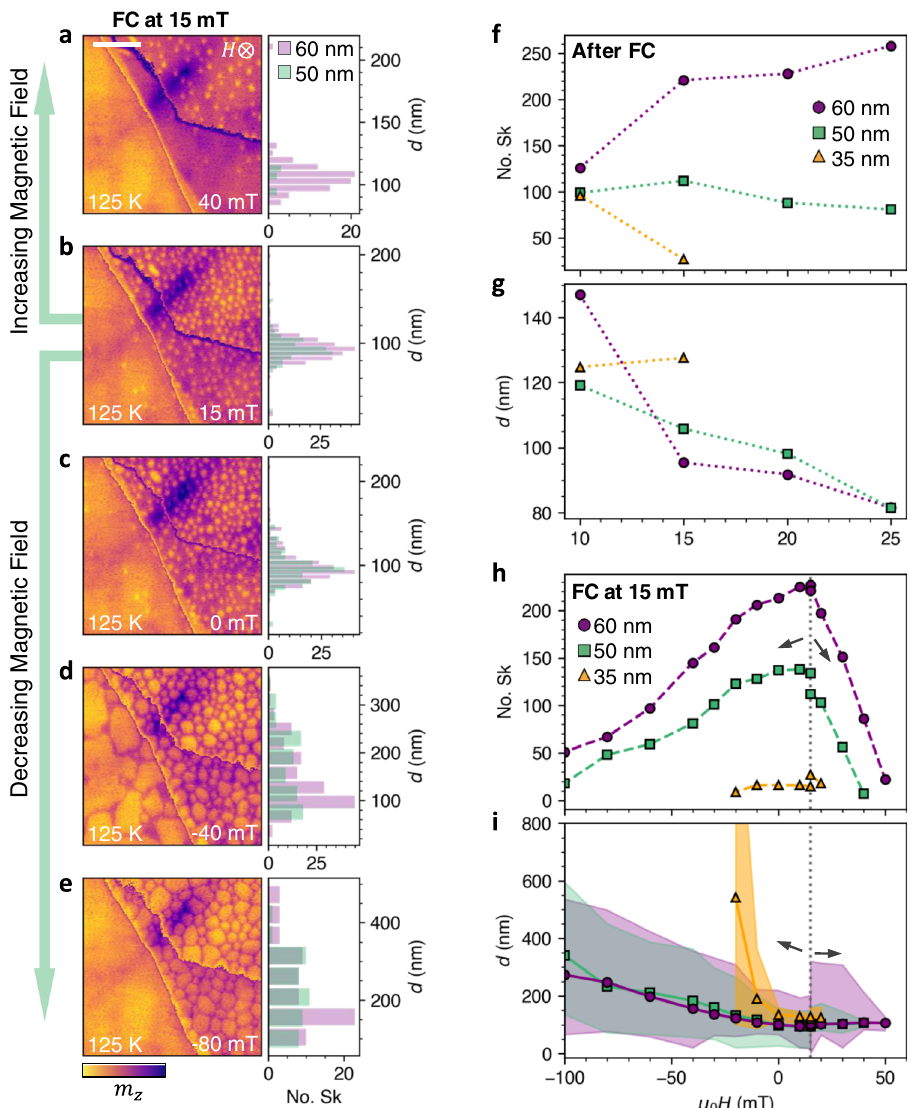
Fig. 5 Formation of skyrmions by fi eld-cooling. a – e Scanning transmission x-ray microscopy (STXM) images of the Fe 3 GeTe 2 (FGT) fl ake acquired as a function of applied magnetic fi eld after fi eld-cooling (FC) the sample from 200 to 125 K under an applied fi eld of 15 mT. The colourmap is proportional the normalised out-of-plane magnetisation of each thickness region. The scale bars are 1 μ m. The histograms plot the distribution of the skyrmion size in the 60 nm (purple) and 50 nm (green) thickness regions. f , g The number and diameter, d , of skyrmions determined after FC at a range of applied magnetic fi elds in the 60 nm (purple), 50 nm (green) and 35 nm (orange) thickness regions. h , i The number and diameter of the skyrmions determined for increasing and decreasing magnetic fi eld at 125 K, after FC the sample at 15 mT, for each thickness region. Dashed vertical lines and arrows indicate the initial point, and the direction, of the fi eld sweeps. The shaded regions indicate the maximum and minimum d observed at each fi eld